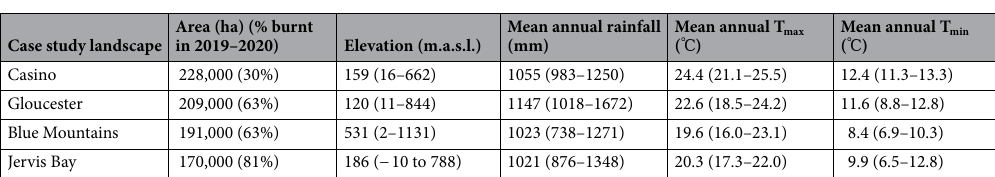
Table 1. Selected case study properties. For mean annual maximum and minimum temperature, area average and range are shown.